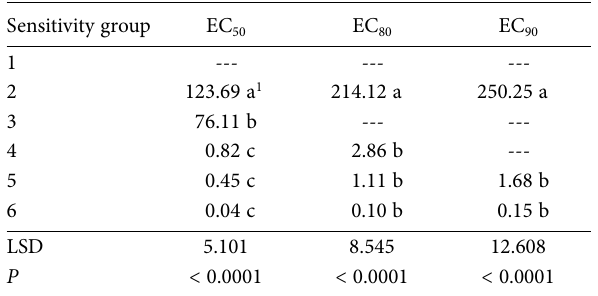
Table 3. Mean EC 50 , EC 80 and EC 90 values for different mefenoxam sensitivity groups identified after in vitro exposure of Phytoph- thora citrophthora and Phytophthora nicotianae isolates to different mefenoxam concentrations.